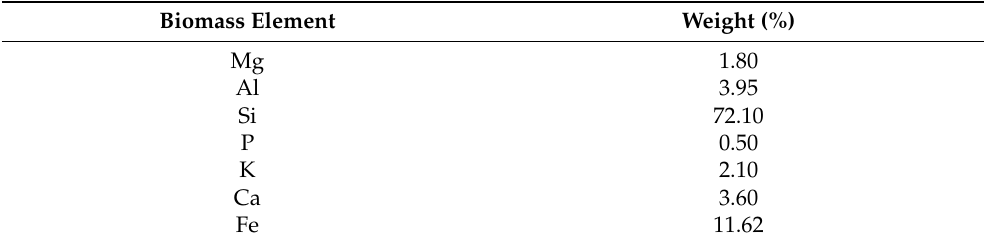
Table 1. Chemical composition of PKS cellulose ash obtained by XRF analysis. Biomass Element